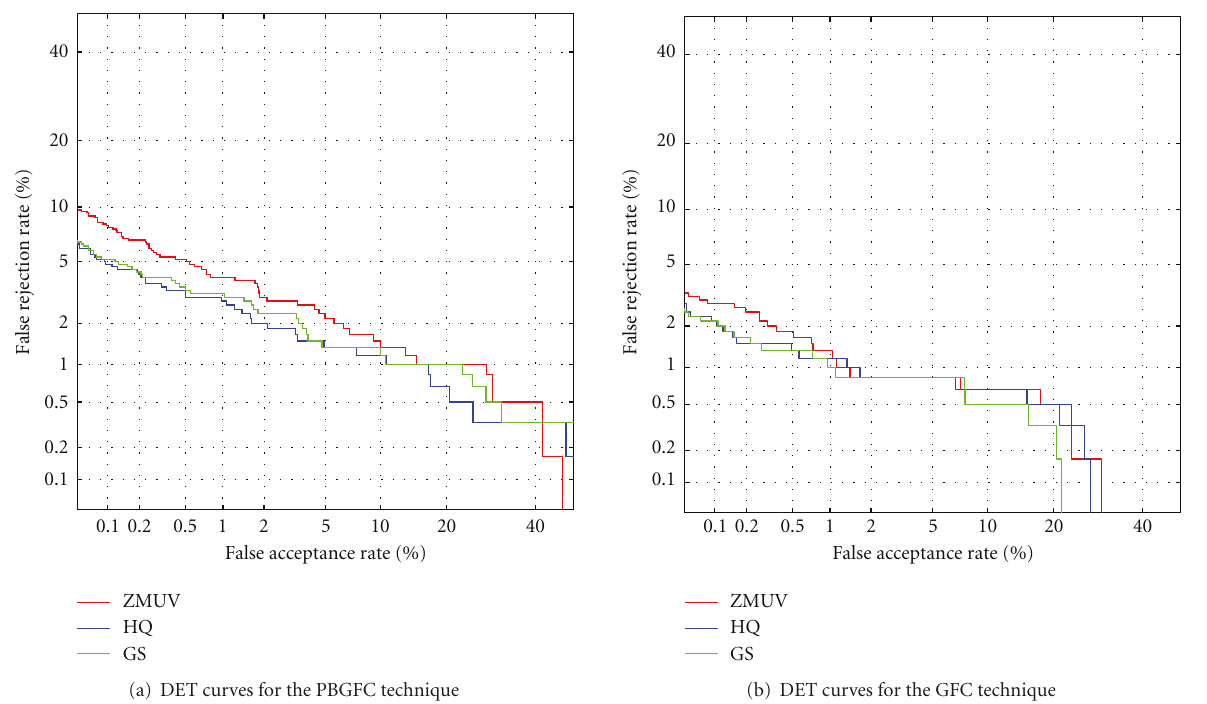
Figure 16: Comparison of the impact of di ff erent normalization techniques on the face verification performance on the XM2VTS